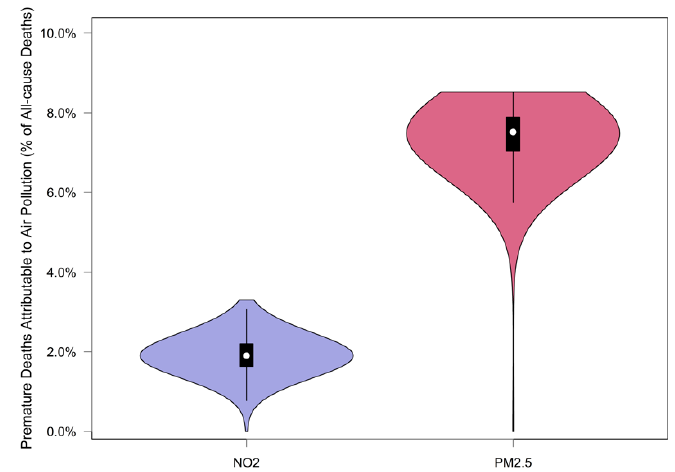
Figure 3. Range and distribution of estimated premature deaths attributable to PM 2.5 and NO 2 as a percentage from all-cause deaths for zero-exposure scneario.